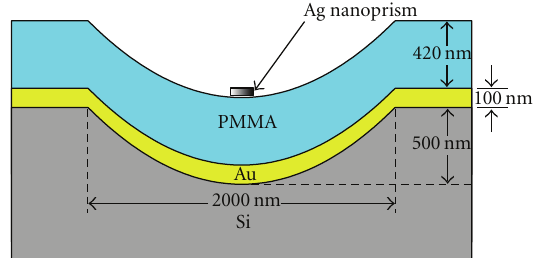
Figure 3: The schematic drawing of the proposed parabolic reflec- tor